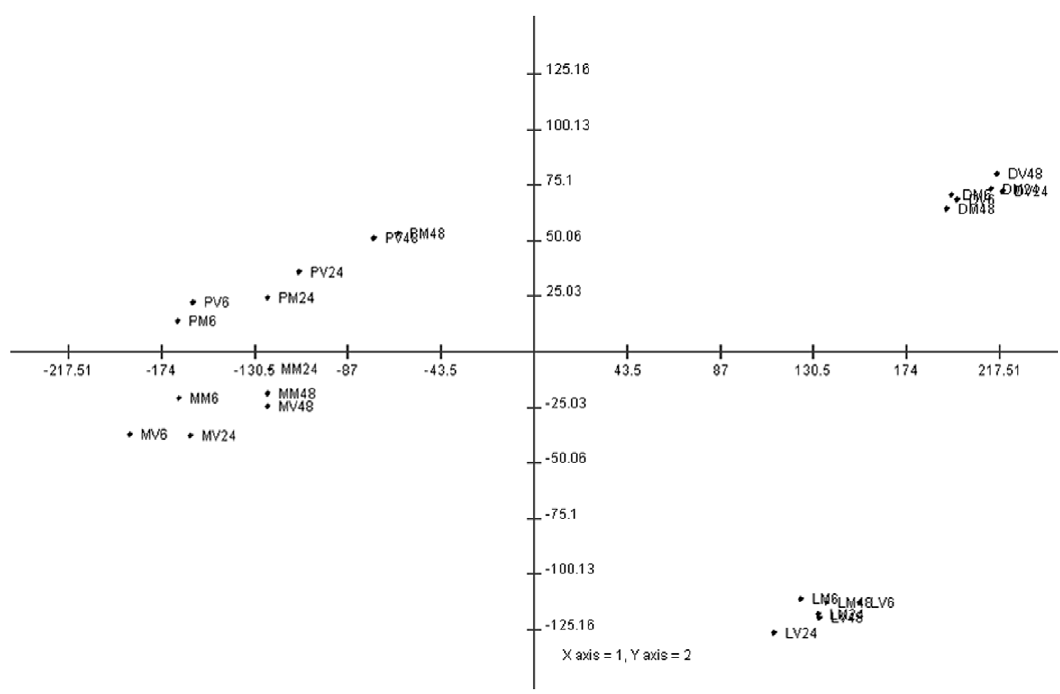
Figure 2. Principal Component Analysis ( PCA ) Plot. The principal component analysis is performed on all samples and on all microRNAs with standard deviation over 1. The normalized log ratio values have been used for the analysis. Abbreviations: LM (LNCaP Mock); LV (LNCaP Virus-treated); DM (DU145 Mock); DV (DU145 Virus-treated); PM (PBL Mock); PV (PBL Virus-treated); and MM (MDM Mock); MV (MDM Virus-treated). The LNCaP and DU145 cell lines form tight cluster indicating minimal variation with regard to infection status and time. PBLs and MDMs are more spread suggesting variation due to both and time and infection status.